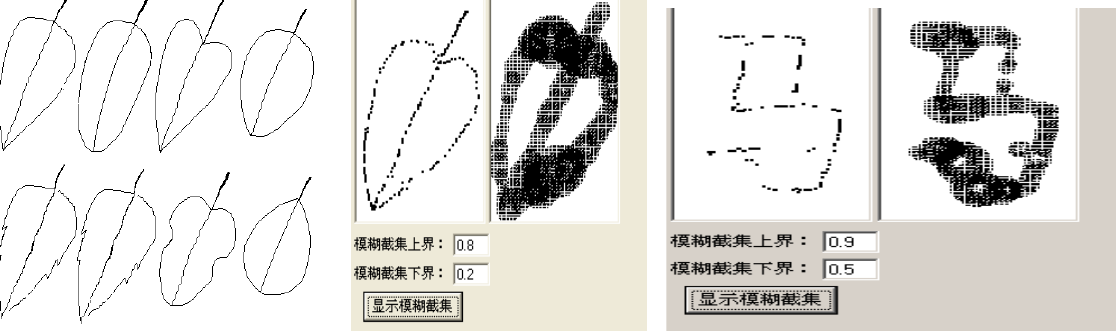
Figure 9. Emergence of memory pattern and fuzzy cut set induced by conversion degree function η (x).